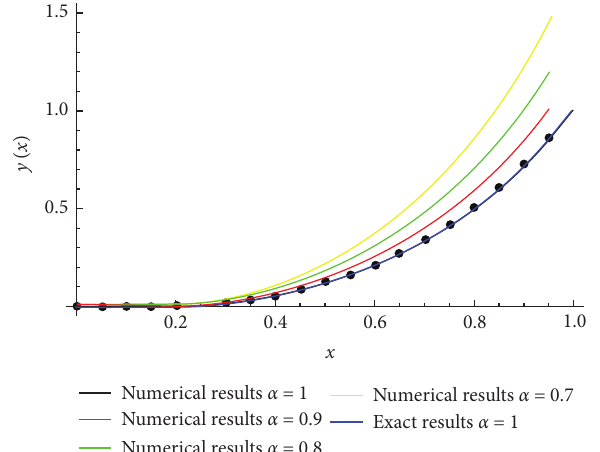
Figure 3: Numerical solutions (different α ) and exact solution ( α � 1 ) with n � 6 for Example 2.